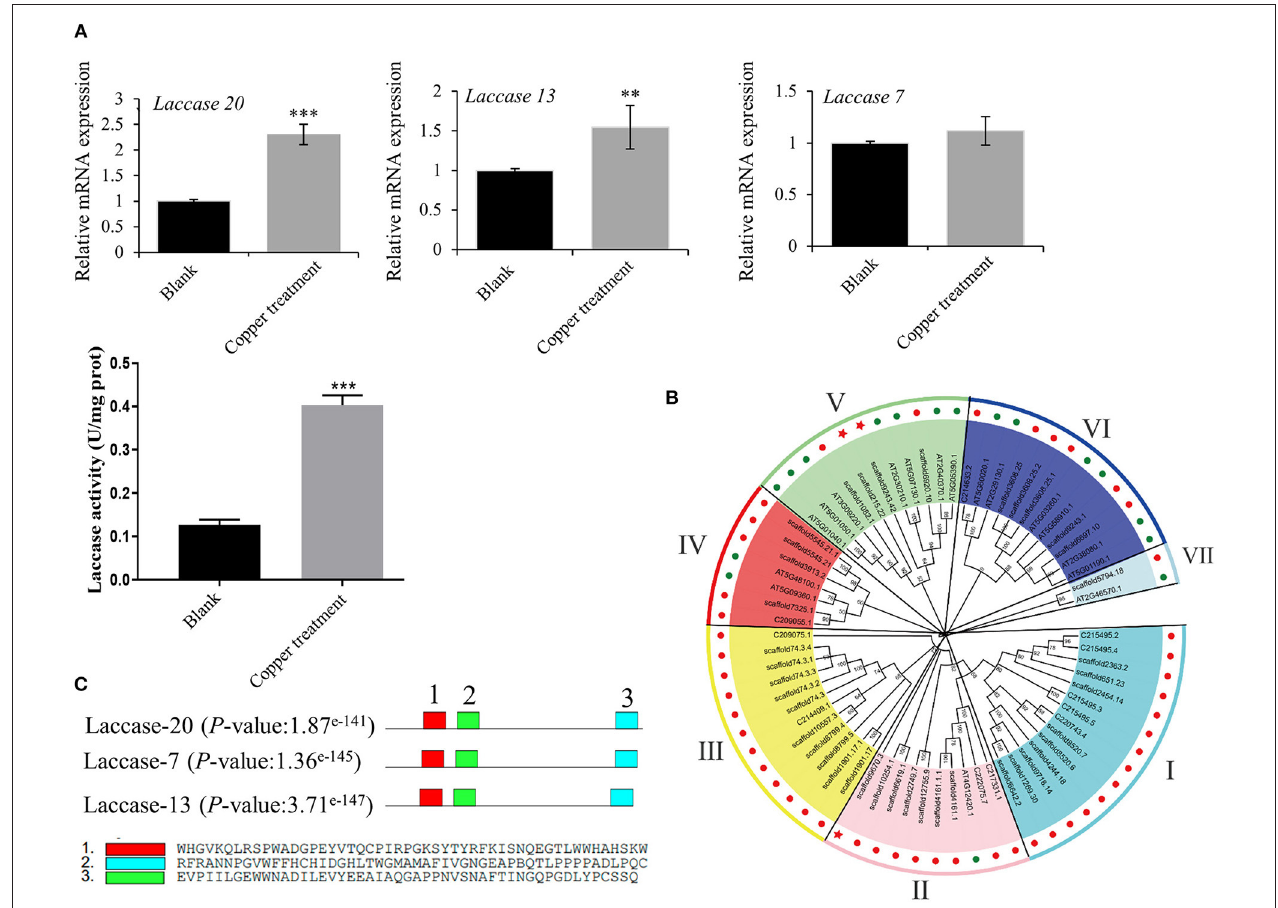
FIGURE 6 | Bioinformatics and enzyme activity analyses of copper ion-induced laccase. (A) mRNA expression levels of laccase 20, laccase 13, and laccase 7 in untreated and treated samples were checked by reverse transcription-quantitative PCR (RT-qPCR). Crude proteins were extracted from root of Salvia miltiorrhiza , and laccase activity was measured in untreated and treated samples using an ELISA kit. (B) A phylogenetic tree of laccases in Salvia miltiorrhiza (red dots) and Arabidopsis thaliana (green dots) was constructed using the maximum likelihood (ML) method with bootstraps in MEGA X software. Our target laccases (laccase 20, laccase 13, and laccase 7) were marked with a red pentagram. (C) A motif analysis of three key laccases was performed using MEME Suite. ** P -value < 0.01, *** P -value <